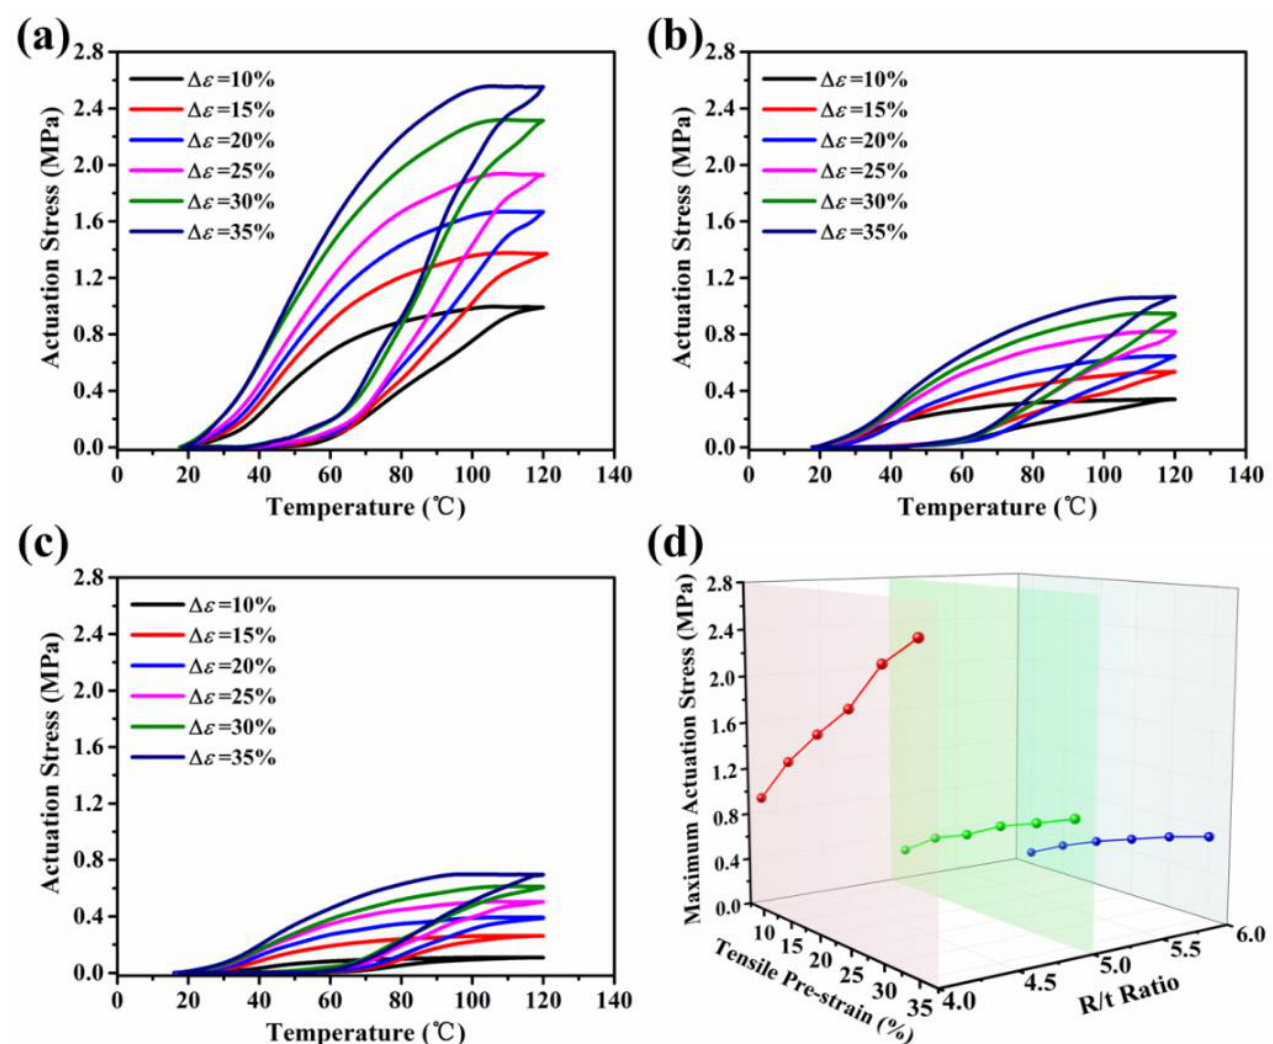
Figure 9. Actuation stress of SLM – fabricated active SMA honeycomb arrays: ( a ) S-C4; ( b ) S-C5; ( c ) S-C6; ( d ) maximum actuation stress.